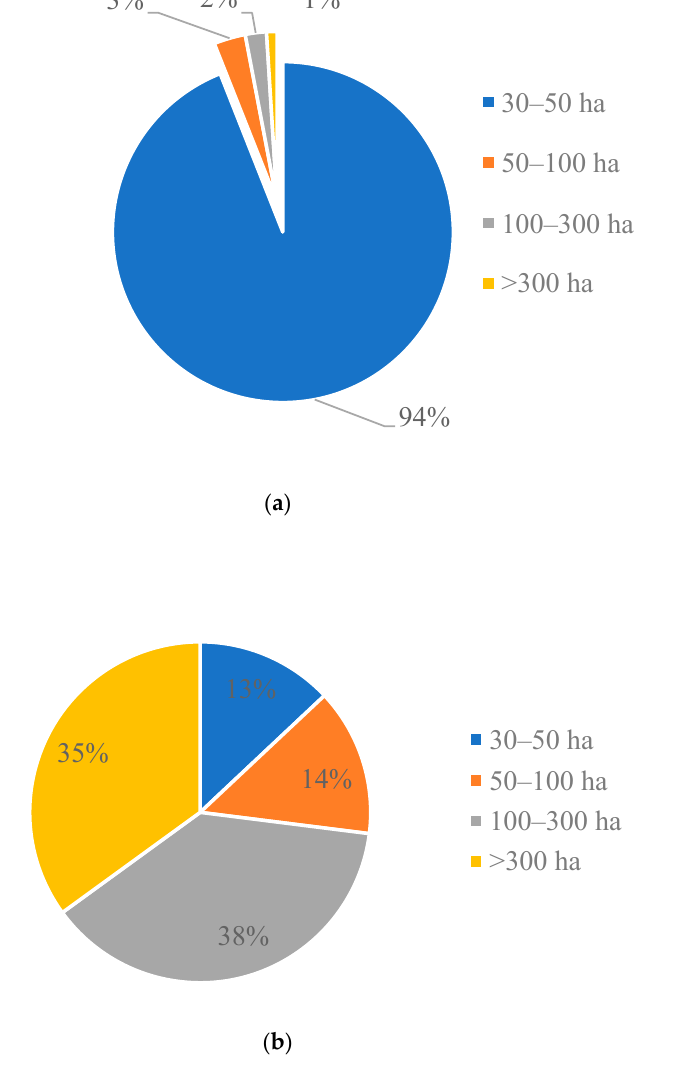
Table 4. Reasons that encourage farms to insure crops.